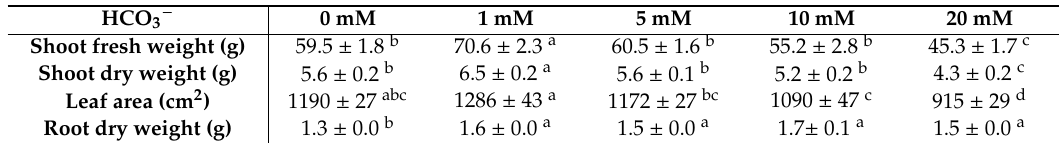
Table 2. Shoot fresh and dry weights, leaf area and growth rate of pepper plants grown under 0, 1, 5, 10 and 20 mM HCO3-. Experiment 2. Values are means ± S.E. of 8 replicates, with di ff erent letters within a row denoting significant di ff erences between means (post-hoc LSD p < 0.05). HCO 3 −